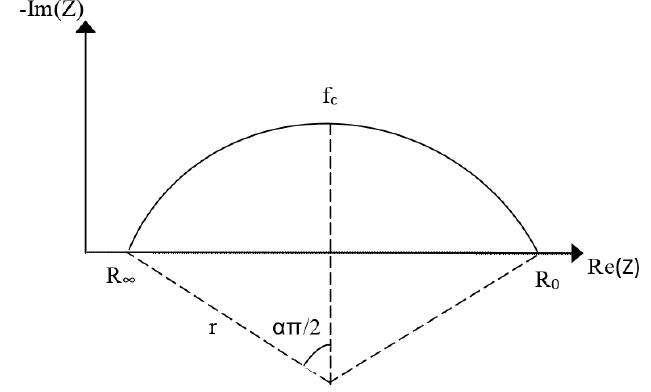
Figure 3. Cole – Cole trace diagram (reprinted from ref. [28]). Figure 3. Cole–Cole trace diagram (reprinted from ref.